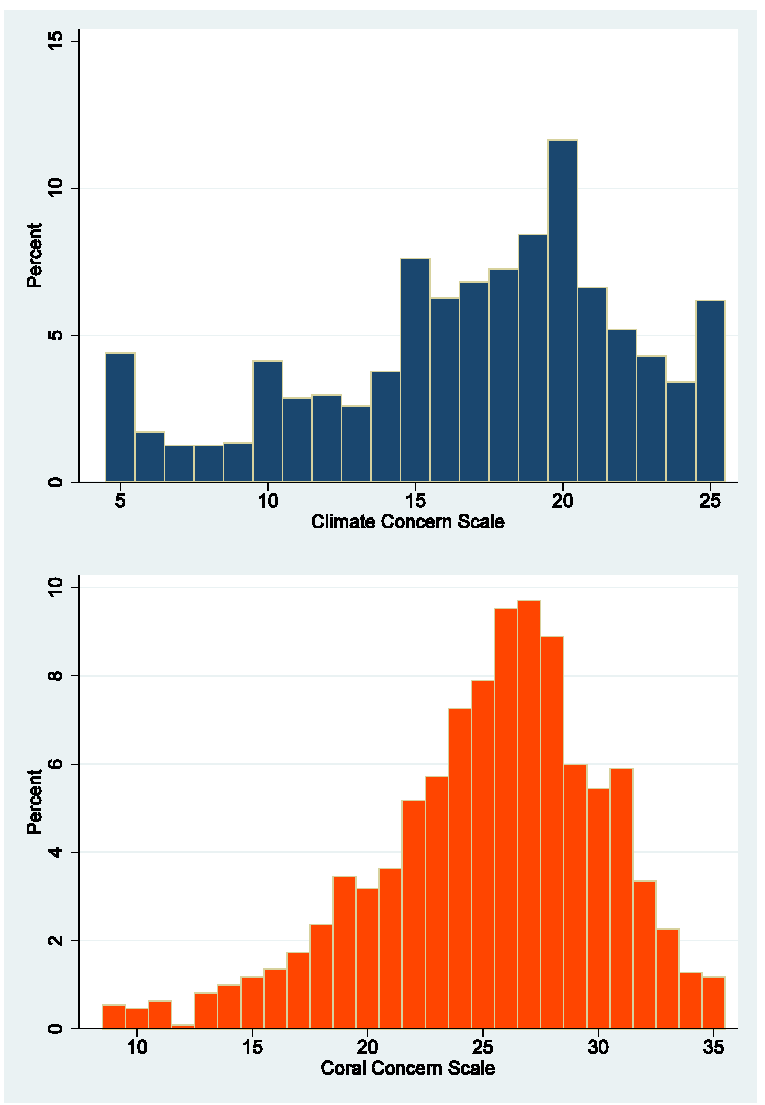
Figure 6. Percentages for respondents’ scores within the scales of concern for climate change and for coral reefs. The climate scale compiled five responses, and the coral scale compiled seven